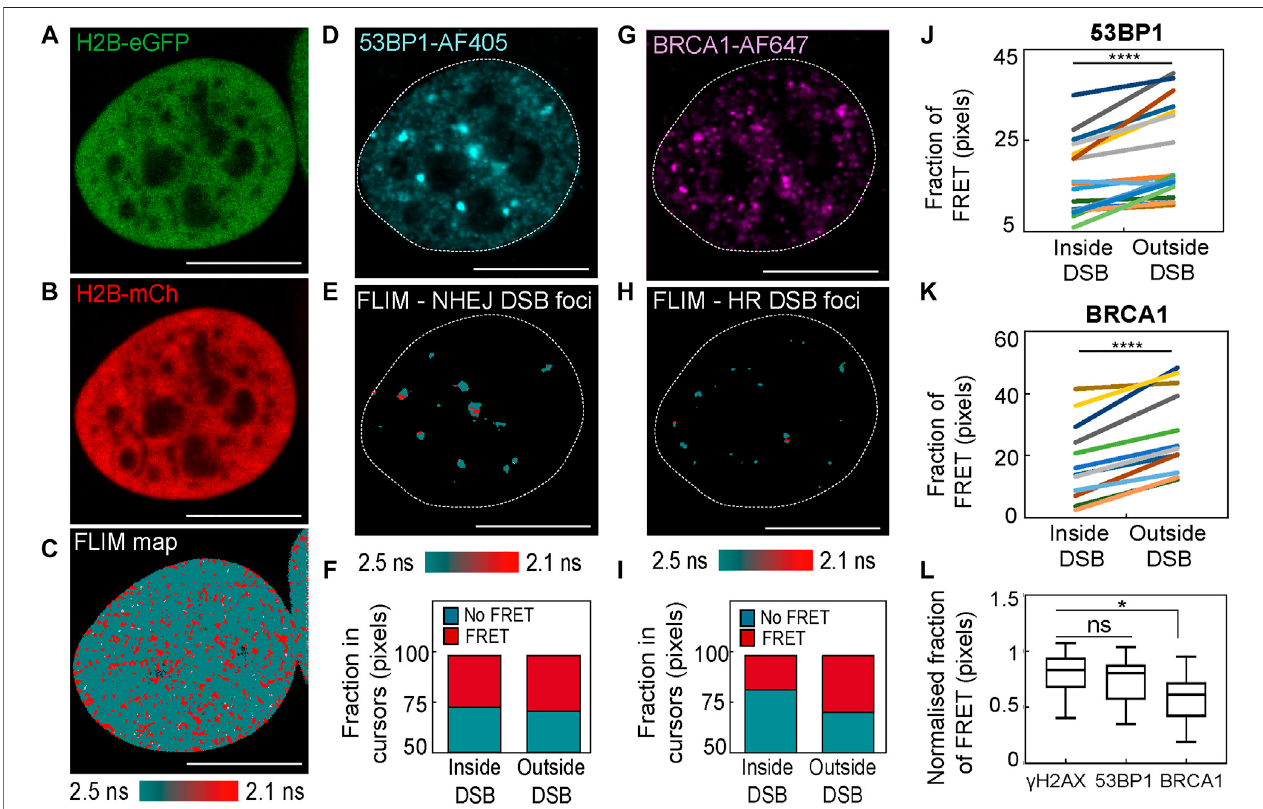
FIGURE 4 | An IF-based mask analysis of DSB histone FRET heterogeneity in the DIvA cell system. (A,B) DIvA nucleus co-expressing the histone FRET pair H2B- eGFP (A) and H2B-mCh (B) that has been treated with4OHTfor 2 h and fi xed withIF against different DNA repair proteins. (C) FLIM map of the cellpresented in panels (A,B) pseudo-colored to report histone FRET (red pixels). (D) IF against NHEJ DNA repair protein 53BP1 (53BP1-AF405) in the cell presented in panels (A – C) . (E,F) Pseudo-colored histone FRET map from panel (C) with mask based on the 53BP1-AF405 signal (D) applied to select NHEJ DSB foci (E) and the fraction of pixels reporting histone FRET (red pixels) within versus outside of this mask (F) . (G) IF against HR DNA repair protein BRCA1 (BRCA1-AF647) in the cell presented in panels (A – C) . (H,I) Pseudo-colored histone FRET map from panel (C) with mask based on the BRCA1-AF647 signal (G) applied to select HR DSB foci (H) and the fraction of pixels reporting histone FRET (red pixels) within versus outside of this mask (I) . (J) Quanti fi cation of the fraction of histone FRET (compact chromatin) inside versus outside of 53BP1 identi fi ed NHEJ DSBs after 2 h of 4OHT treatment across multiple nuclei (N (cid:1) 18 cells, two biological replicates). (K) Quanti fi cation of the fraction of histone FRET (compact chromatin) inside versus outside of BRCA1 identi fi ed HR DSBs after 2 h of 4OHT treatment across multiple nuclei (N (cid:1) 12 cells, two biological replicates). (L) A quantitative comparison of the fraction of histone FRET (compact chromatin) inside γ H2AX labeled foci (all DSBs) versus 53BP1 foci (NHEJ DSBs) and BRCA1 foci (HR DSBs) normalized to the fraction of histone FRET in the surrounding nucleoplasm (N ≥ 12 cells, two or three biological replicates). The box and whisker plot shows the minimum, maximum, and sample median. In (J,K) , **** p < 0.0001 (paired t -test). In (L) , * p < 0.05 and ns > 0.05 (unpaired t -test).